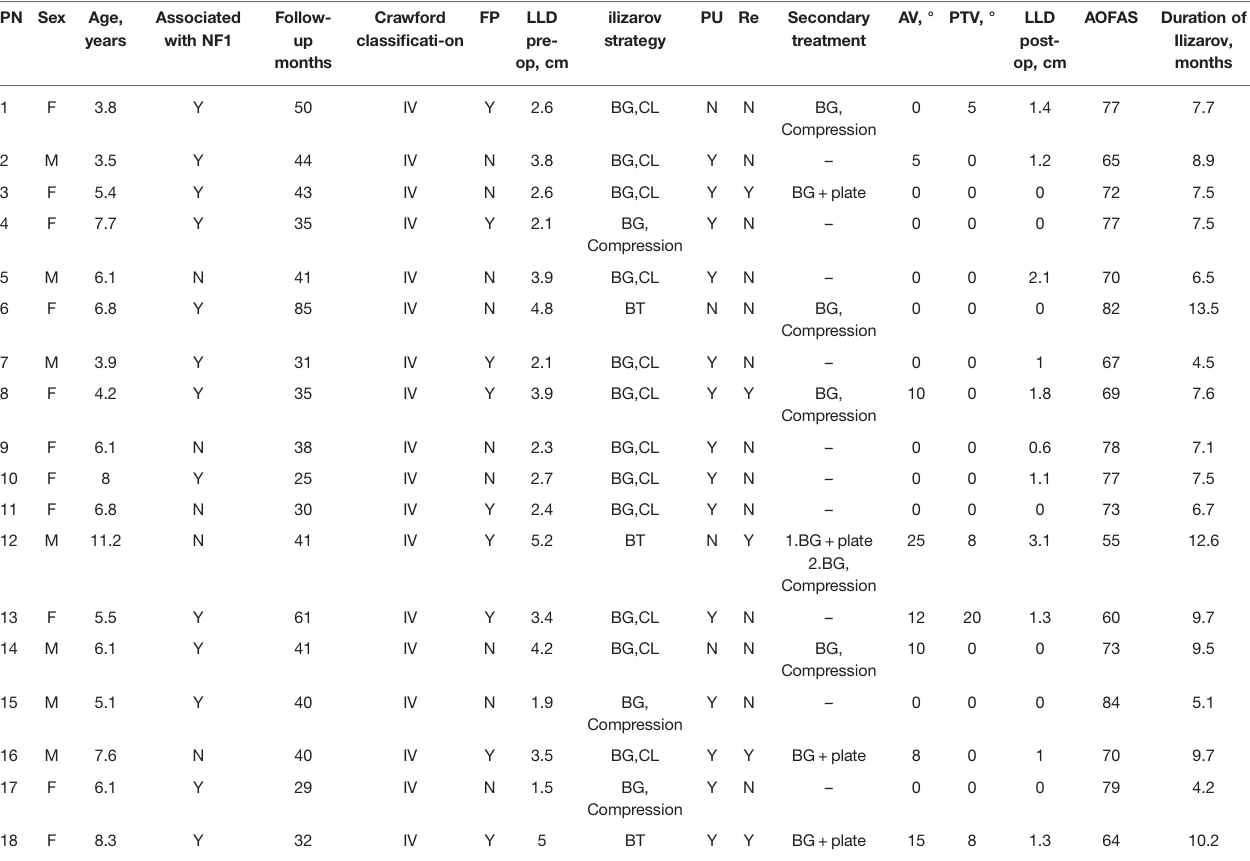
TABLE 3 | Patients ’